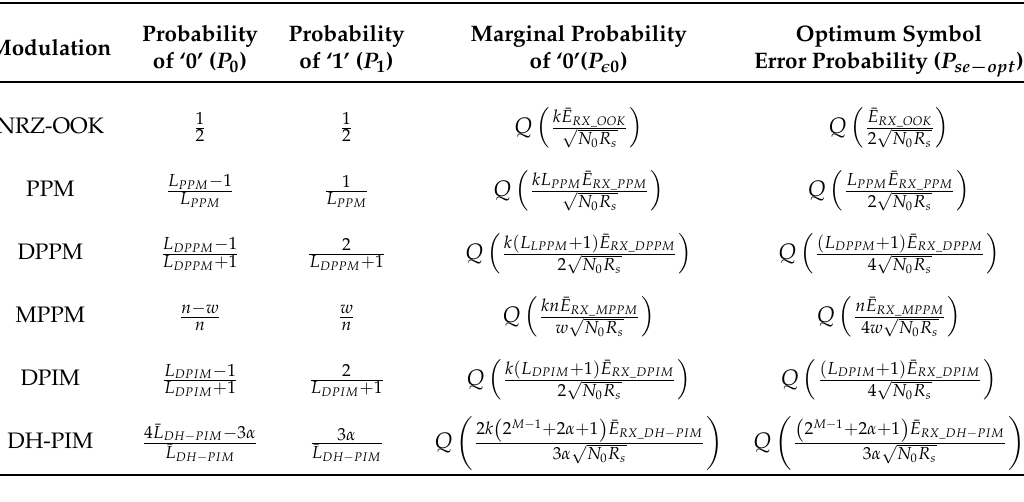
Table 3. Comparison of error probabilities of digital pulse modulation